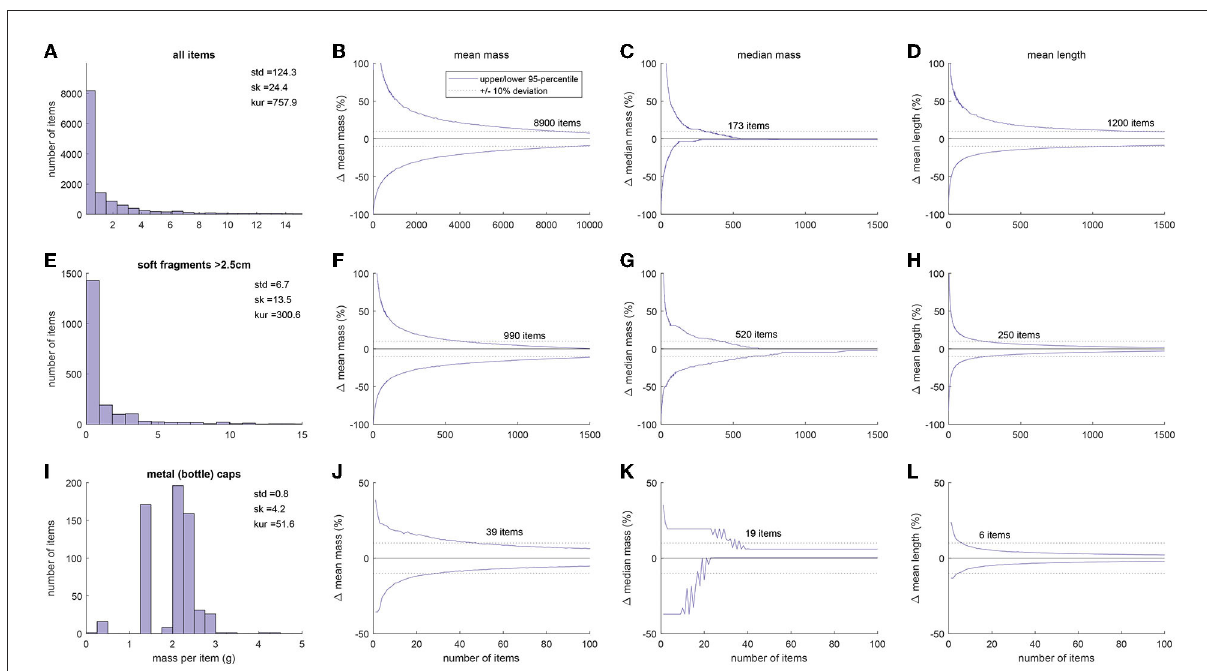
FIGURE5 Examples of the sampling size requirement based on all items (A–D) , soft fragments > 2.5 cm (E–H) , and bottle caps (I–L) . The sampling size requirement is shown for an accurate representation of mean mass (B, F, J) , median mass (C, G, K) , and mean length (D, H, L) , based on a 95% confidence interval, represented as a deviation from the value based on the complete dataset. The dashed horizontal lines indicate ± 10%. In (A, E, I) the distribution of the items is shown, including the standard deviation (std), skewness (sk), and kurtosis (kur), indicating item class